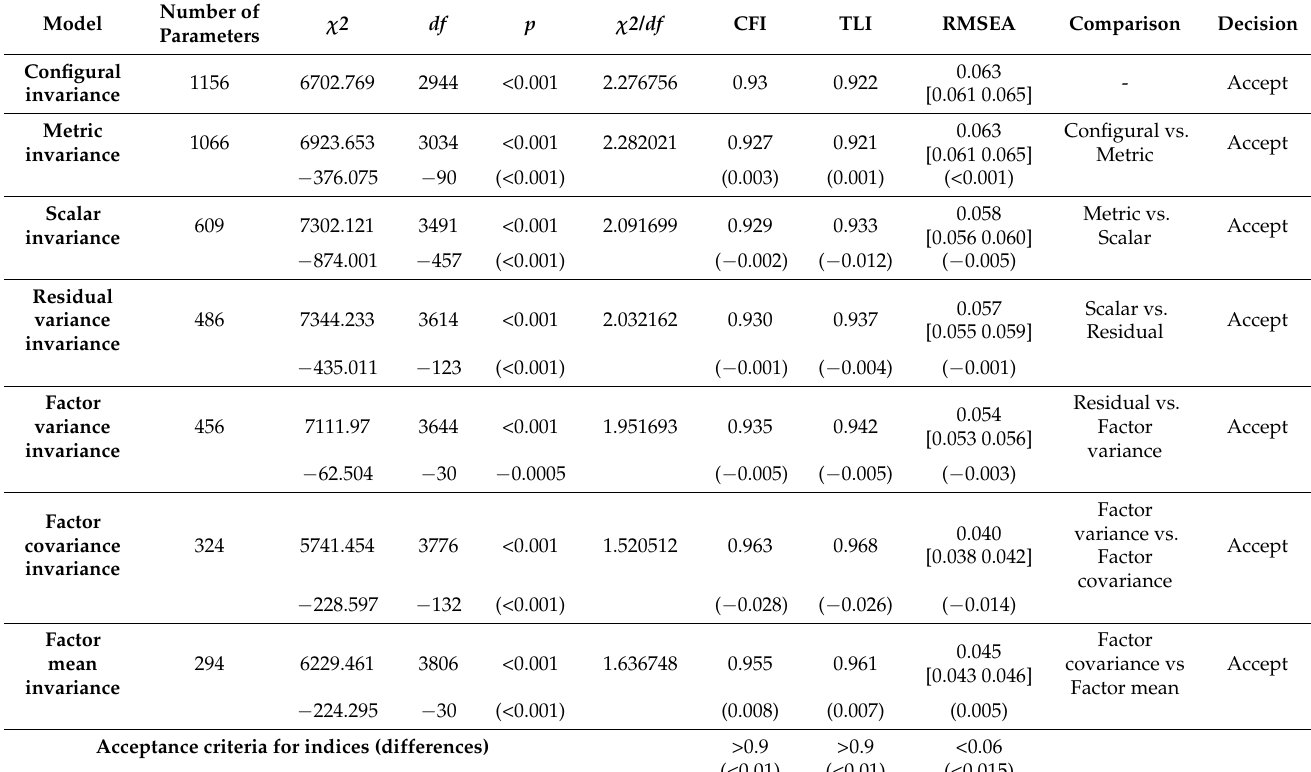
Table 4. MGCFA using mothers’ samples from the USA ( n = 281), South Africa ( n = 372), Nigeria ( n = 344) and India ( n = 289).